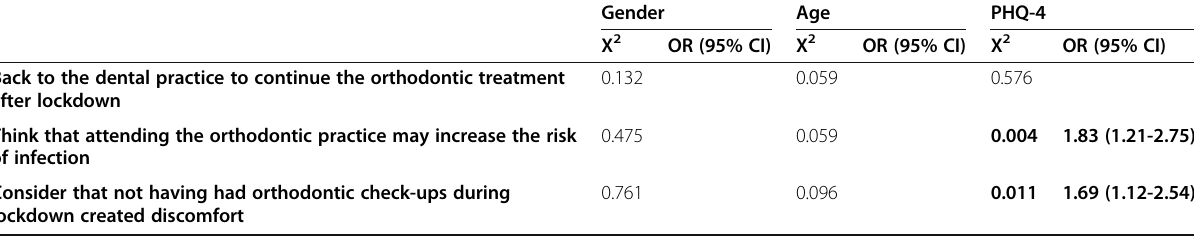
Table 4 Chi-square test and regression analysis for question related to the orthodontic treatment, and gender, age, and PHQ-4 (sample